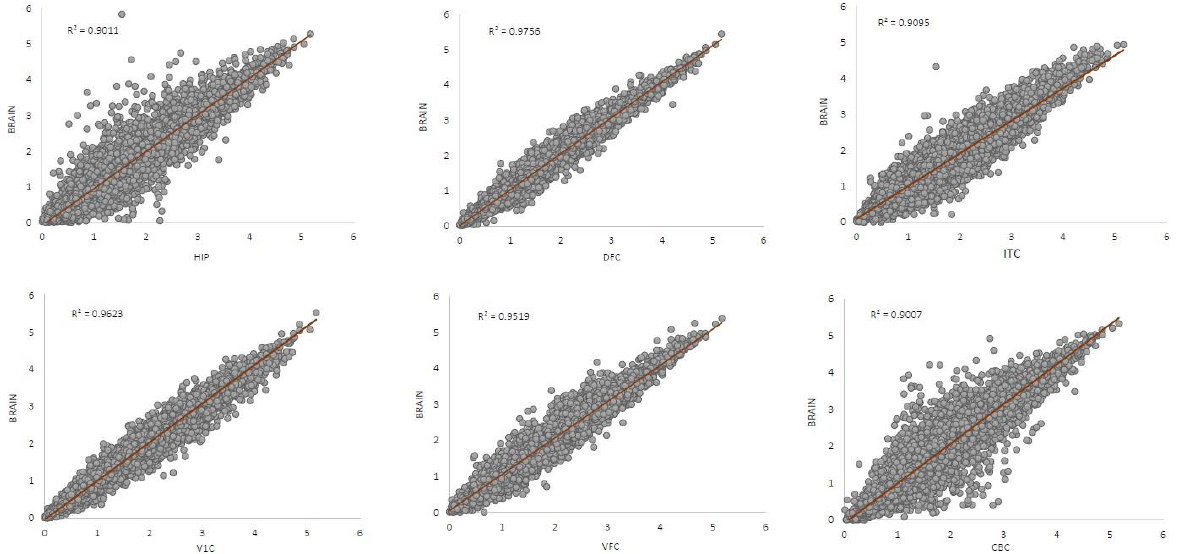
Figure 1. Z-ratio correlation among different brain structures and the brain as a whole. HIP. Hippocampus, DFC. Dorsofrontal Cortex, ITC. Inferior Temporal Cortex, V1C. Visual Cortex, VFC. Ventrofrontal Cortex, CBC. Cerebellar Cortex.